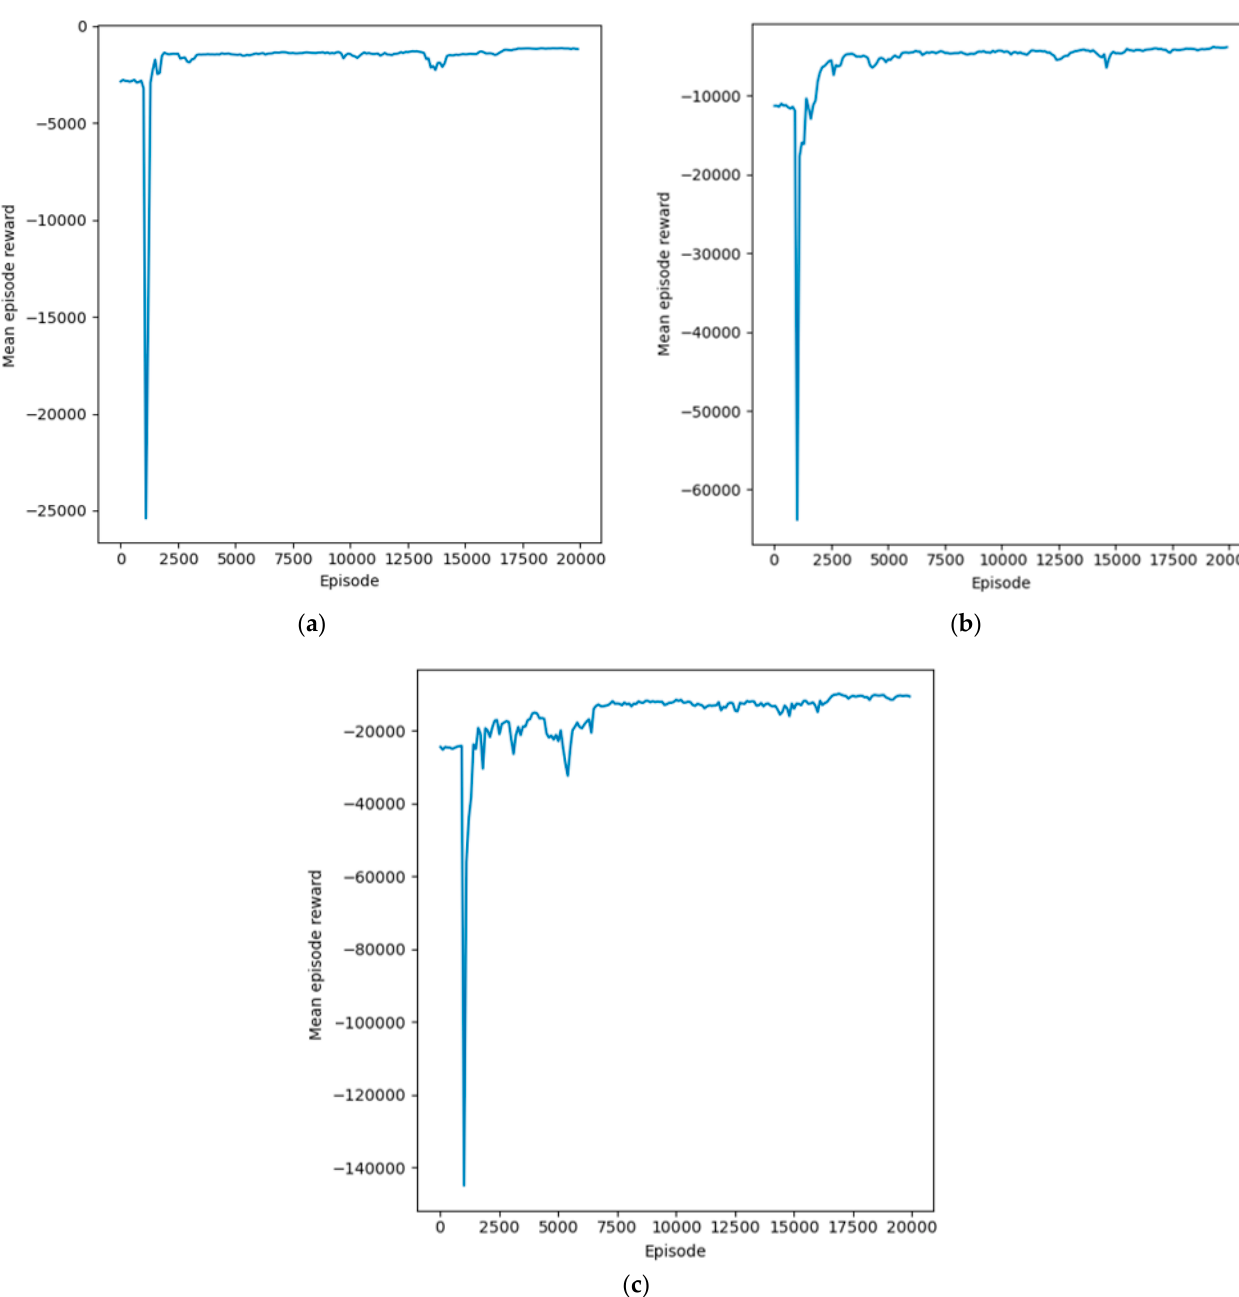
Figure 5. The reward of multiple cooperative USVs with formation generation policies for 40,000 episodes with different numbers of USVs: ( a ) mean episode reward for the team of 3 USVs during formation generation policies training over 20,000 episodes; ( b ) mean episode reward for the team of 5 USVs during formation generation policies training over 20,000 episodes; ( c ) mean episode reward for the team of 7 USVs during formation generation policies training over 20,000 episodes.